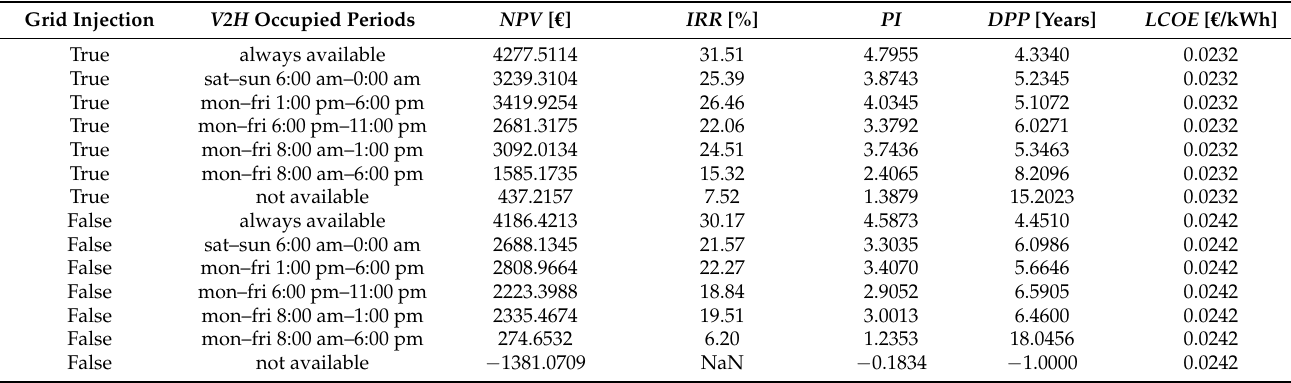
Table 7. Economical results for 1.5 kWp PV setup.